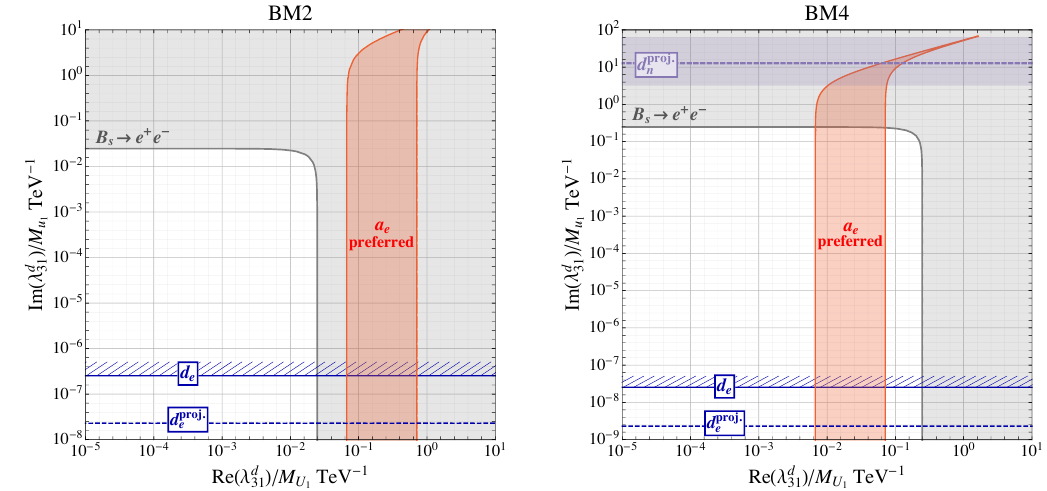
Figure 4 . Constraints on the U 1 leptoquark parameter space in the plane of the complex coupling (cid:21) d divided by the leptoquark mass for the benchmark points BM2 and BM4, left and right panel, 31 respectively). The gray region is excluded by B s ! e + e (cid:0) at the 95% C.L.. The red shaded region corresponds to the parameter space the can address the anomaly in the anomalous magnetic moment of the electron. The solid (dashed) blue lines represent the current constraint (projected sensitivity) from the electron EDM. In the right panel, the dashed purple line represents the projected sensitivity from the neutron EDM, with the purple band re(cid:13)ecting the uncertainty in the nucleon matrix element (cid:12) ~ G n